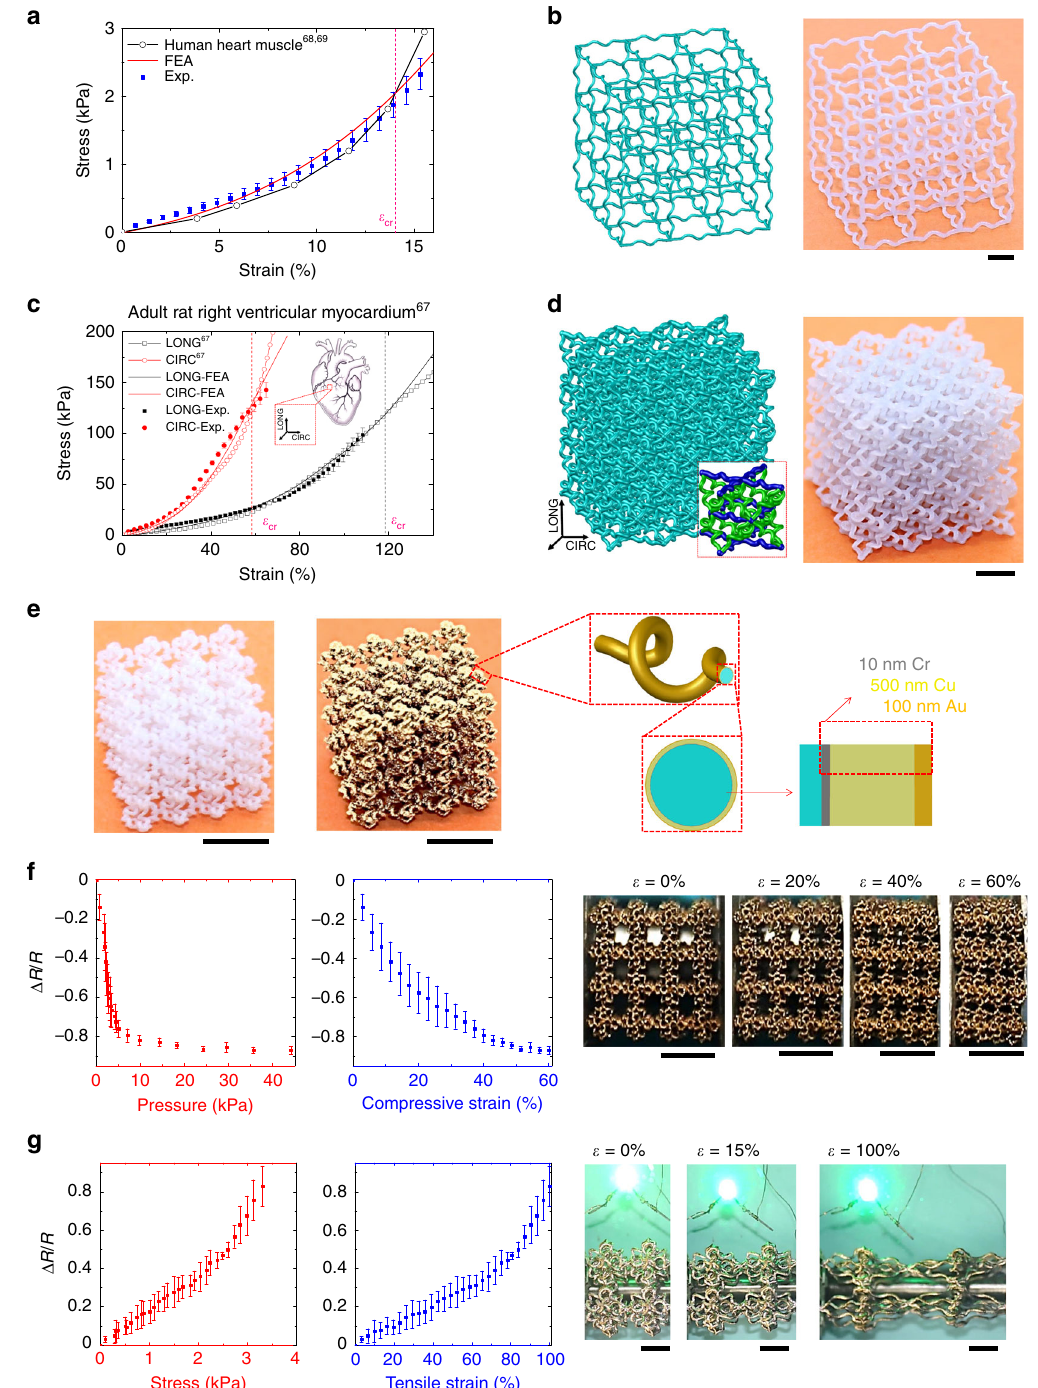
Fig. 5 Bio-mimetic designs and demonstrative applications. a Typical passive stress – strain curves of the human heart muscle 68,69 , arti fi cial network materials, with corresponding FEA results for the latter. Here, the mechanical testing of arti fi cial network materials was performed at 25 °C. b Geometric model and optical image of the arti fi cial network material in a . c Stress – strain curves of right ventricular myocardium of adult rat 67 along the circumferential and longitudinal directions, along with the results of arti fi cial network materials and corresponding FEA results. Here, the mechanical testing of arti fi cial network materials was performed at 23 °C. d Geometric model and optical image of the arti fi cial network material in c . e Optical images of a soft octahedral network before and after magnetron sputtering. A thin coating of 10 nm Cr, 500 nm Cu, and 100 nm Au (from inside to outside) is generated by the sputtering. f Relative resistance change and effective pressure measured during the uniaxial compression of soft octahedral network materials, along with the deformed con fi gurations. g Relative resistance change and effective tensile stress measured during the uniaxial stretching of soft octahedral network materials, along with the deformed con fi gurations. A green LED connected with the stretched conducting network serves as a demonstration. Scale bars, 5 mm in all